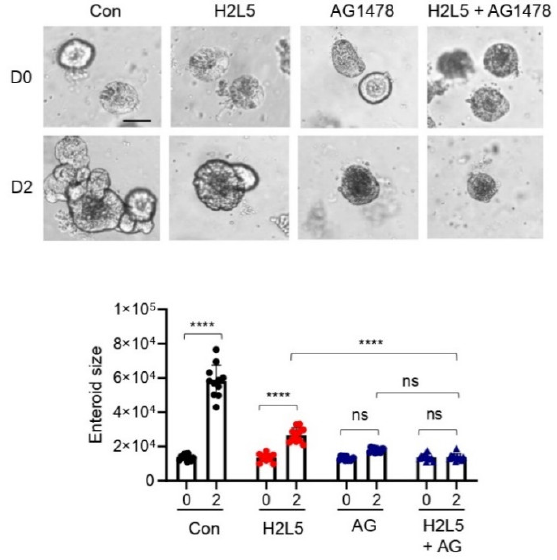
Figure 6. Inhibition of EGFR prevents Lpar5 cKO enteroid growth. Lpar5 cKO enteroids were cultured in the presence of LPA 2 inhibitor H2L5186303 (H2L5), or EGFR inhibitor AG1478 (AG). Representative images of enteroids on D0 and D2 (upper panel) and average surface area of enteroids (lower panel) are shown. Bar = 50 µ m. **** p < 0.0001, and ns = not significant by two-way ANOVA with Tukey’s multiple comparison